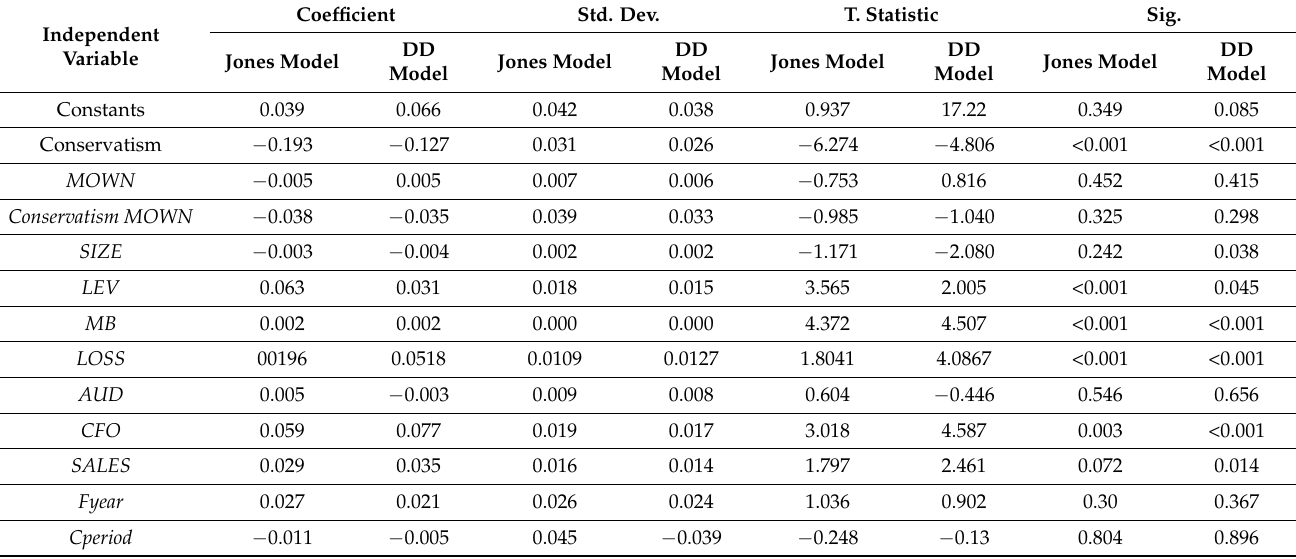
Table 3. The results of the second hypothesis